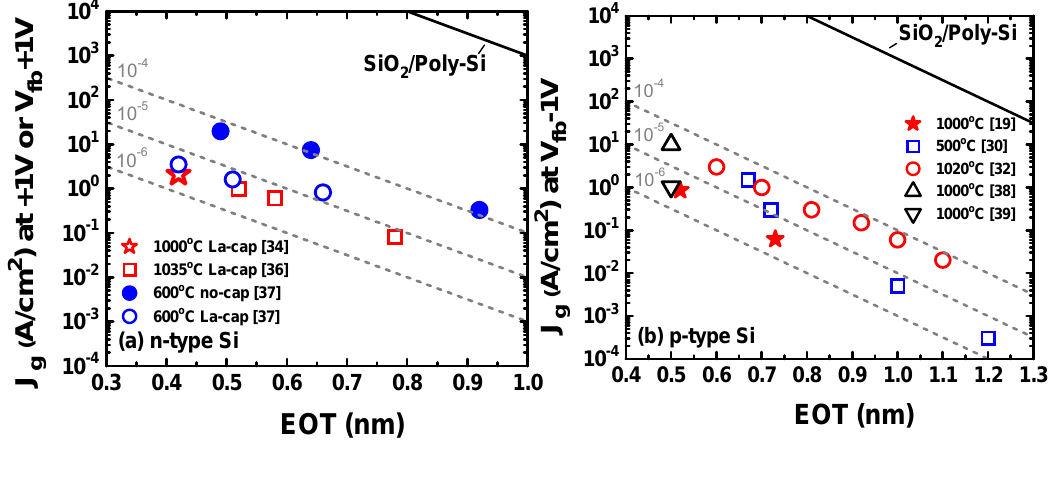
Figure 6. ( a ) EOT-J characteristics for n-type metal-oxide-semiconductor (MOS) g )/HfO /(La-cap) gate dielectrics in literature. J capacitors with (SiO 2 2 V = flatband voltage (V ) + 1 V for [34,37] and at V g fb characteristics for p-type MOS capacitors with (SiO = V − 1 V for [19,30,32,38,39]. The slopes for ideal SiO is defined at V g fb shown in broken lines with the magnitude in J plots. The maximum process temperatures are indicated in the